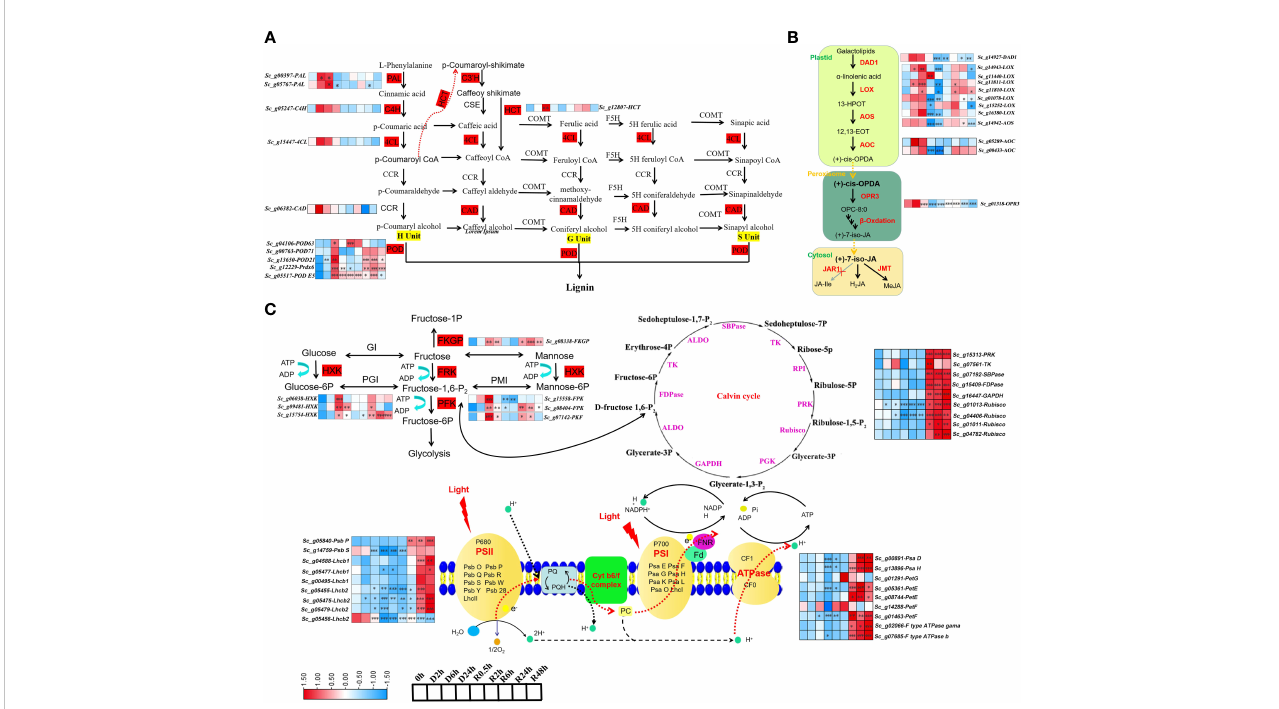
FIGURE 5 The dynamic change of transcript abundance in Key pathway during D-R process (A) alpha-linolenic acid; (B) phenylpropanoid biosynthesis; (C) fructose and mannose metabolism, photosynthesis and calvin cycle in S. caninervis during D-R process. DETs that up-and down-regulated are indicated in red and blue, respectively;FPKM values were used to heatmap; |Log 2 (fold change)| ≥ 1 (* p <0.05, ** p <0.01, *** p <0.001). Treatments during 24 h of desiccation (D h) and 48 h of rehydration (R